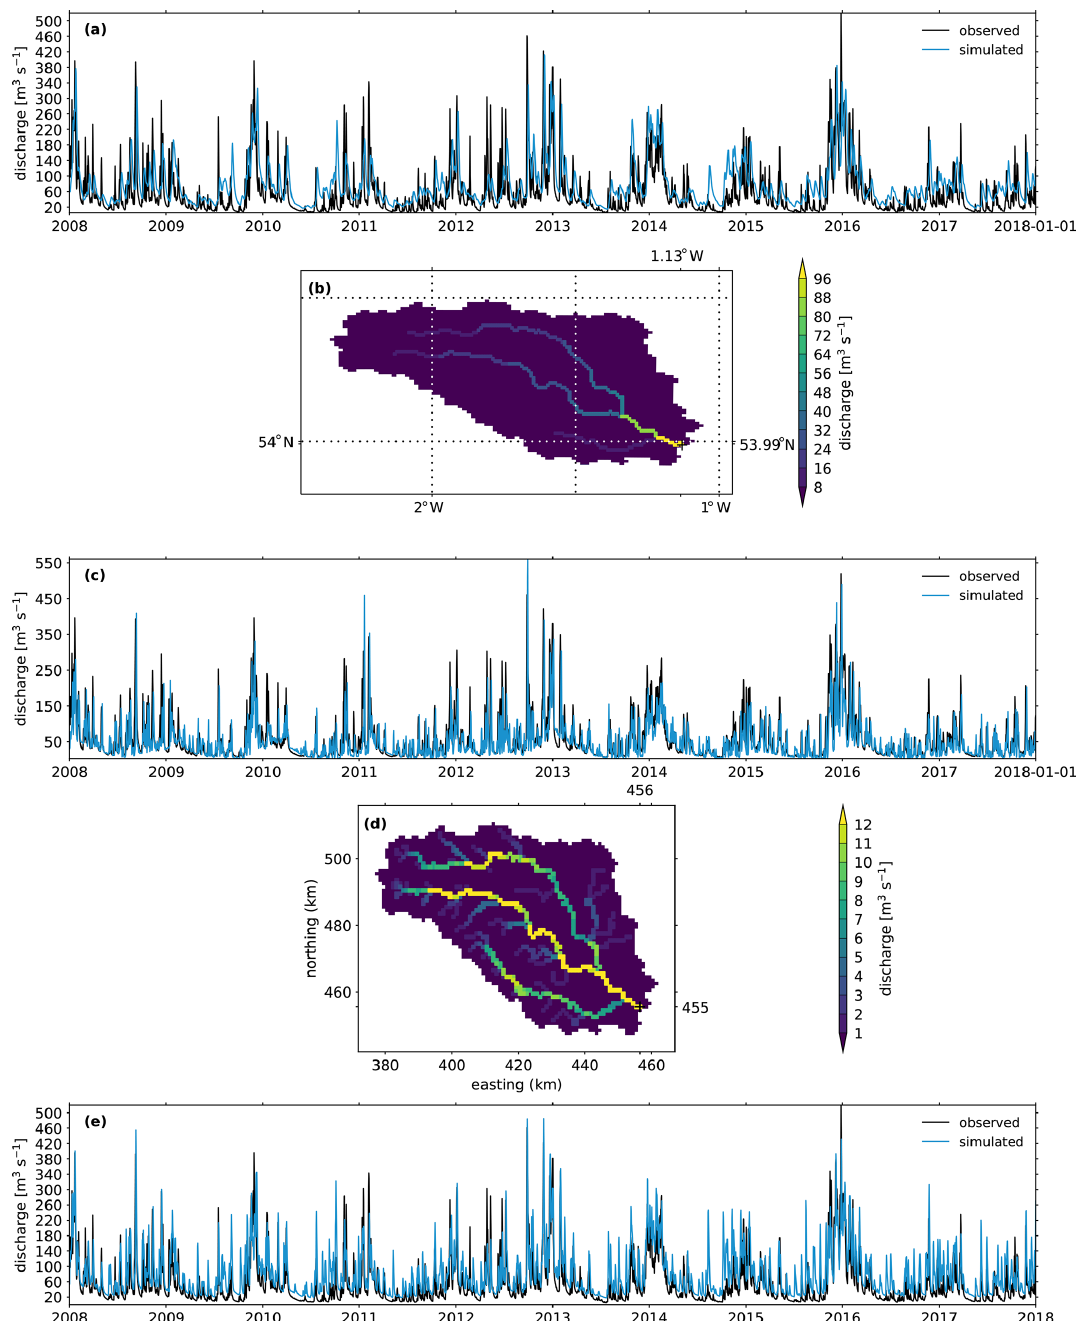
Figure B1. Simulation of the river discharge with the three configurations for the Ouse catchment: (a) observed and simulated hydrographs with configuration 1 at the catchment outlet (1.13 ◦ W, 53.99 ◦ N), (b) gridded simulated discharge with configuration 1 for the last simulation step (1 January 2018), (c) observed and simulated hydrographs with configuration 2 at the catchment outlet (456, 455), (d) gridded simulated discharge with configuration 2 for the last simulation step (1 January 2018), (e) observed and simulated hydrographs with configuration 3 at the catchment